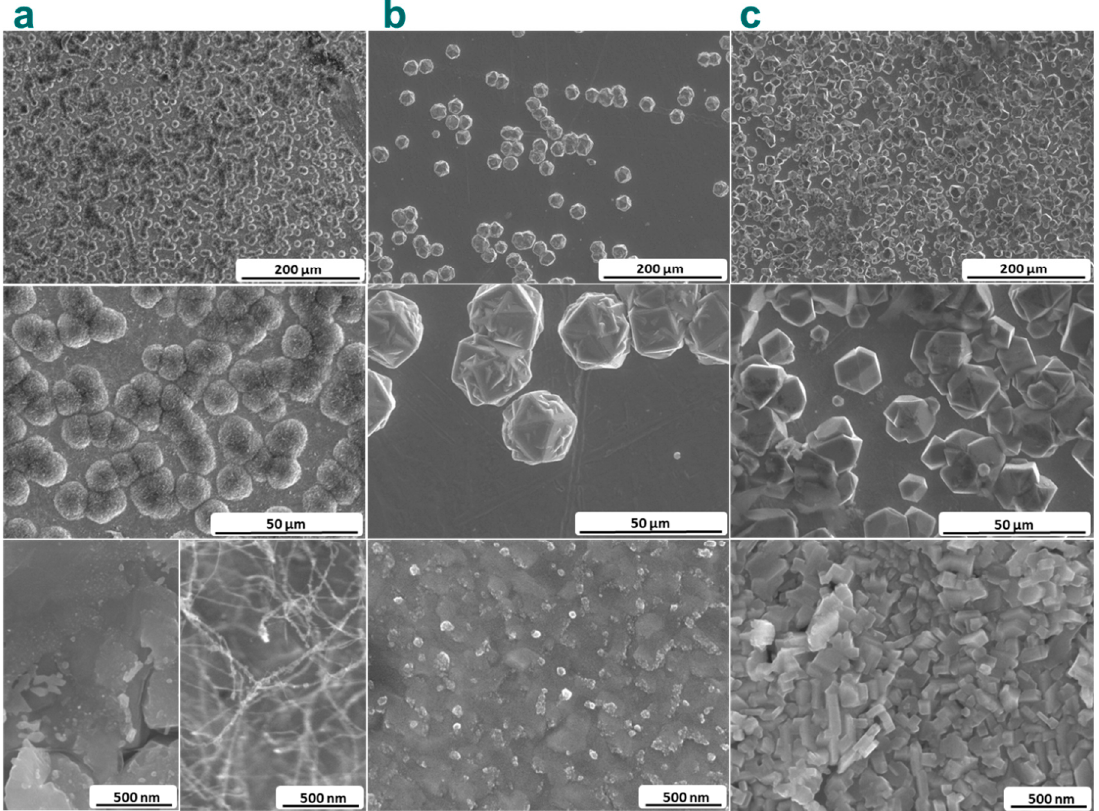
Figure 2. SEM images of the surface of diamond films: Sample 1 ( a ), Sample 2 ( b ) and Sample3( c ), grown at different parameters of gas-jet synthesis. Bottom images were taken in the spaces between microparticles.